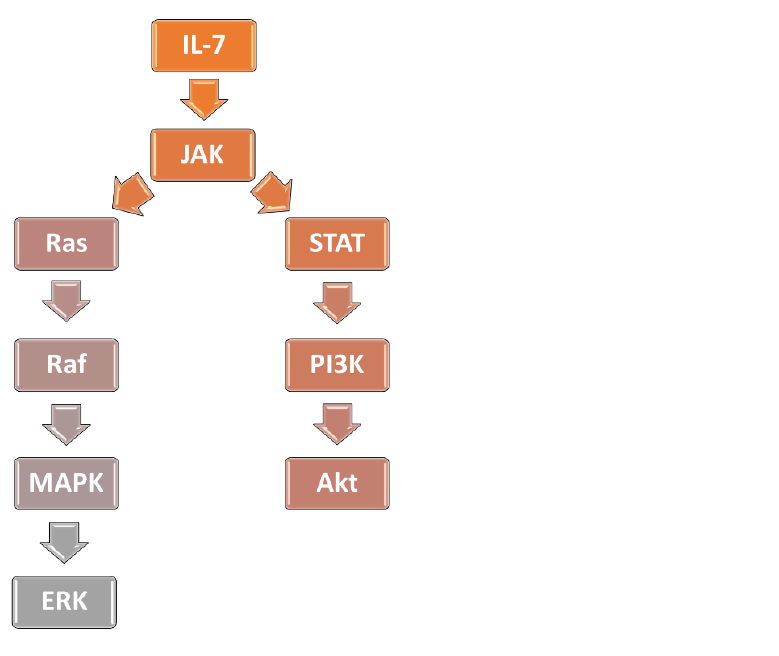
Figure 1. Signaling cascades involved in glucocorticoid resistance.